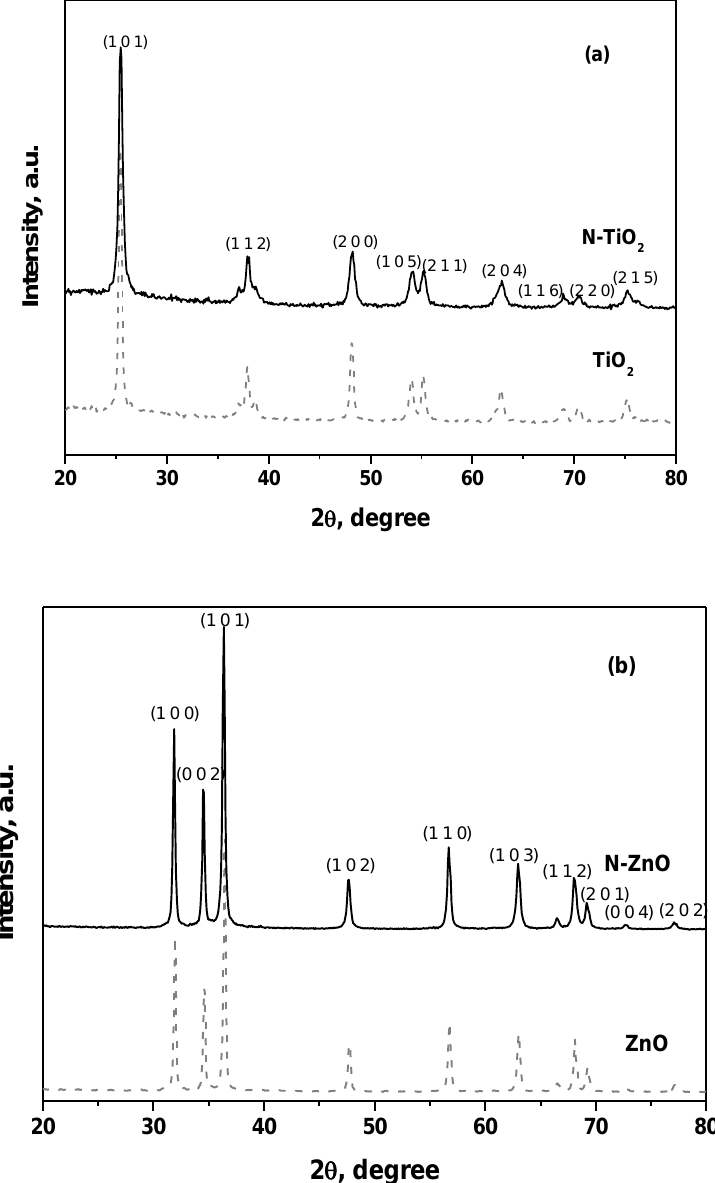
Figure 4. WAXD patterns for ( a ) TiO 2 and N-TiO 2 , as well as ( b ) ZnO and N-ZnO samples in the range of 20 – 80°.